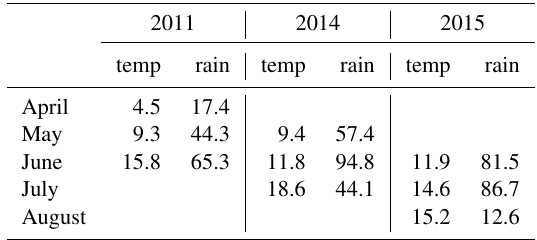
Fig. 2. Typical diurnal variations of the most abundant com- pounds for each season are shown in Fig. 3. Since most of